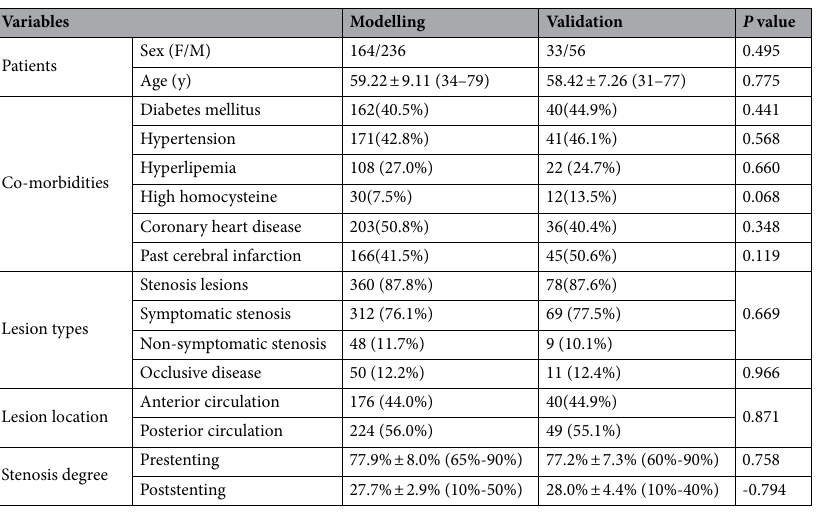
Table 1. Clinical data of patients in the modelling and validation groups with intracranial atherosclerotic diseases. No significant ( P > 0.05) difference existed in the baseline data between the two